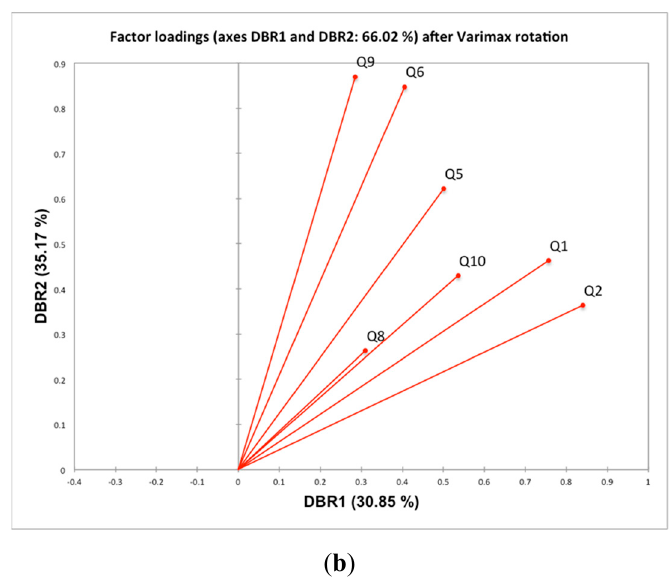
Figure 3. Factor analysis: Factor loadings after varimax rotation. Students views of the use of BIM during the second implementation phase. ( a ) Scree plot; ( b ) factor loadings after varimax rotation.